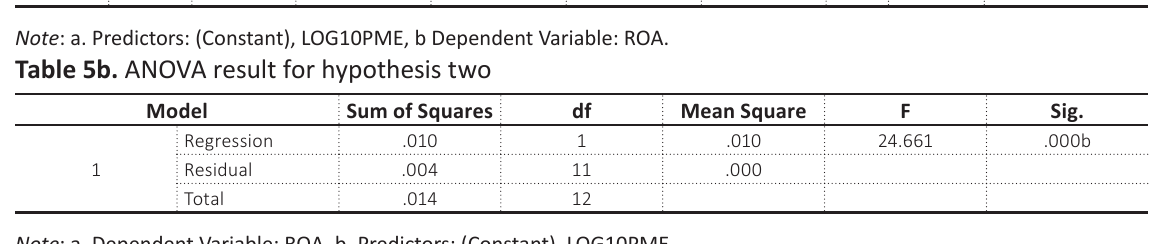
Table 5a. Model summary for hypothesis two Model